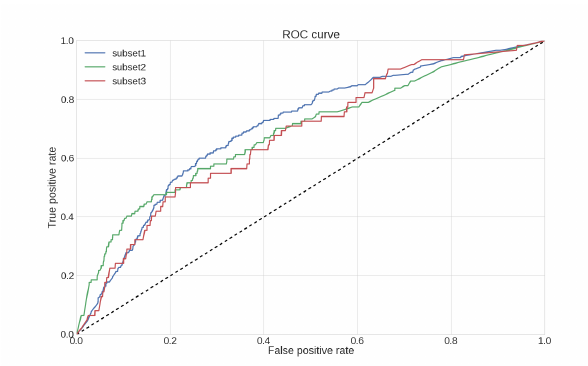
Figure 9: Receiver Operating Characteristic Curve(segmentation threshold=0.10) using Gradient Boosting which further validates the use of polarimetry product in investi- gating landslides. Only 75 top features as obtained from Random forest feature importance was required for the best performing